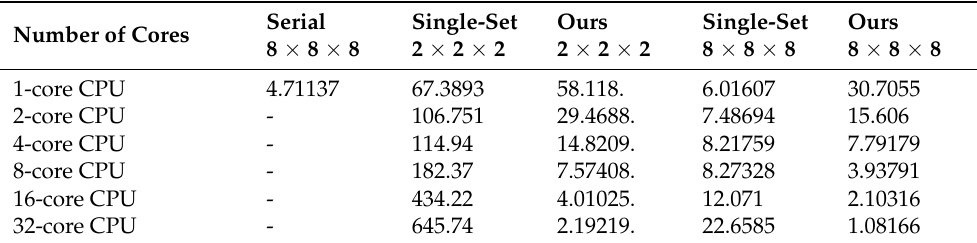
Table 4. The computation time of our proposed parallel multi-set EM algorithm and the parallel single-set histogram modeling algorithm. Number of